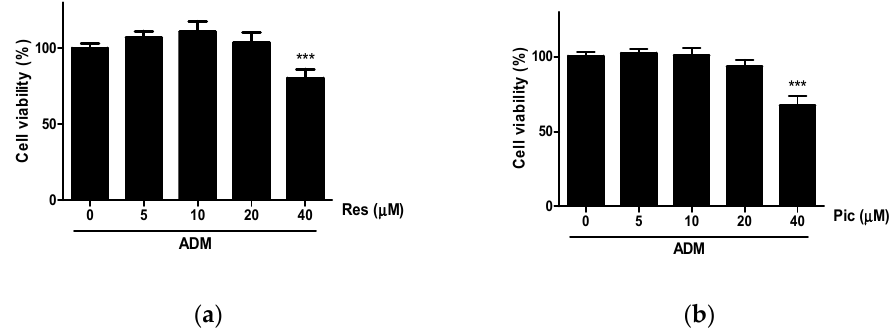
Figure 2. The effect of resveratrol (Res) ( a ) and piceatannol (Pic) ( b ) on the cell viability of human visceral adipose-derived stem cells (vASCs). vASCs were treated with the Res and Pic in the presence of adipogenic differentiation medium (ADM) for two days. Cell viability was quantified using the MTT assay and absorbance was measured at 570 nm. Data are expressed as means ± SD from three independent experiments (*** p < 0.001 vs. ADM-treated-group).